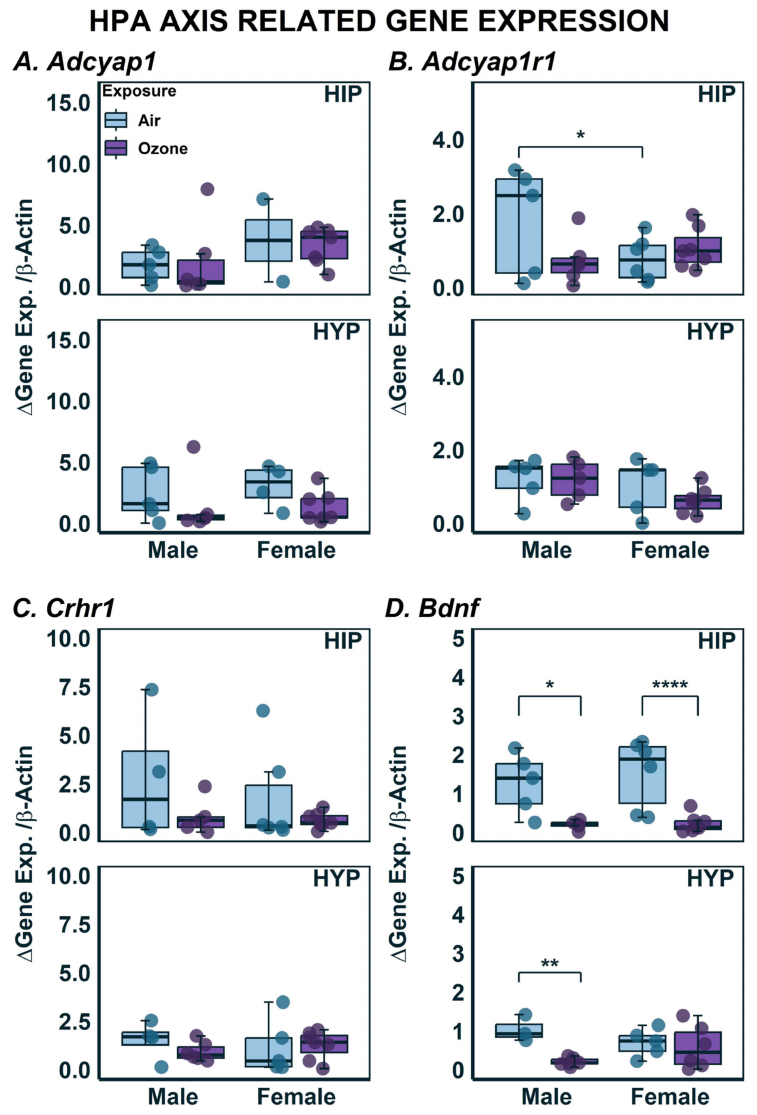
Figure 3. Stress Related Gene Expression in the hippocampus (HIP) and hypothalamus (HYP) following ozone exposure in male and female rats. ( A ) Adcyap1 ; ( B ) Adcyap1r1 ; ( C ) Crhr1; ( D )